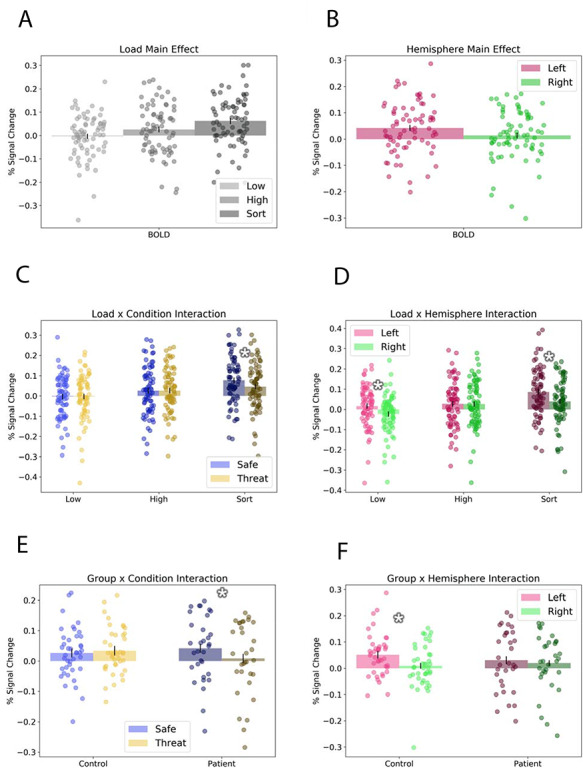
Retention interval fMRI ROI results. Graphs represent significant results from the analysis of the dorsolateral prefrontal cortex ROI analysis. (A) Load main effect: sort trials evoked significantly more activity than high or low trials, and high trials evoked more activity than low trials. (B) Hemisphere main effect: Activity was greater in the left compared to the right hemisphere. (C) Load by condition interaction: There was significantly less activity in threat compared to safe during sort trials. (D) Load by hemisphere interaction: There was significantly less right than left dlPFC activity during sort and low trials. (E) Group by condition interaction: Patients showed significantly less activity during threat compared to safe trials. (F) Group by hemisphere interaction: Controls showed significantly less right than left dlPFC activity. Bars represent means ± SEM. Circles represent individual data points. *Pairwise P-value < 0.05.